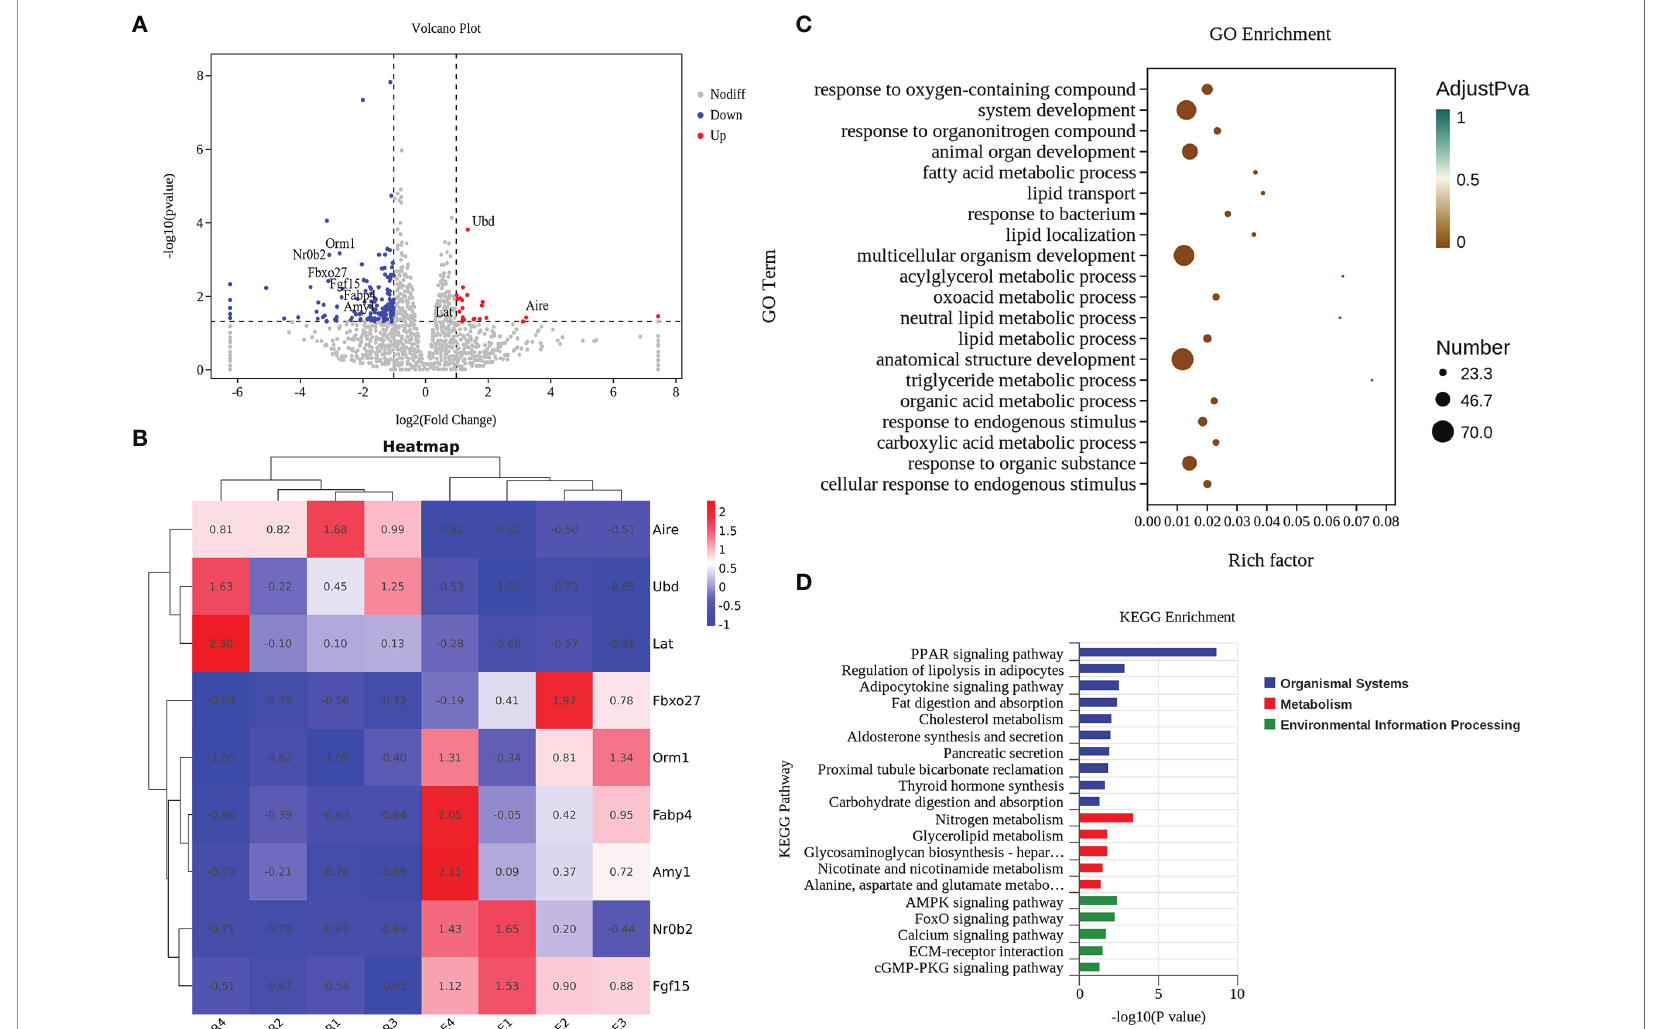
FIGURE 6 | Resveratrol effectively acted by altering characteristic genes and pathways in the jejunal tissue of mice. (A) Volcano plot of differential genes. (B) Cluster analysis of characteristic genes. E: The celiac disease mouse model (APG group). R: The intervention of resveratrol (APG+Re group). (C) GO enrichment analyses. (D) KEGG enrichment